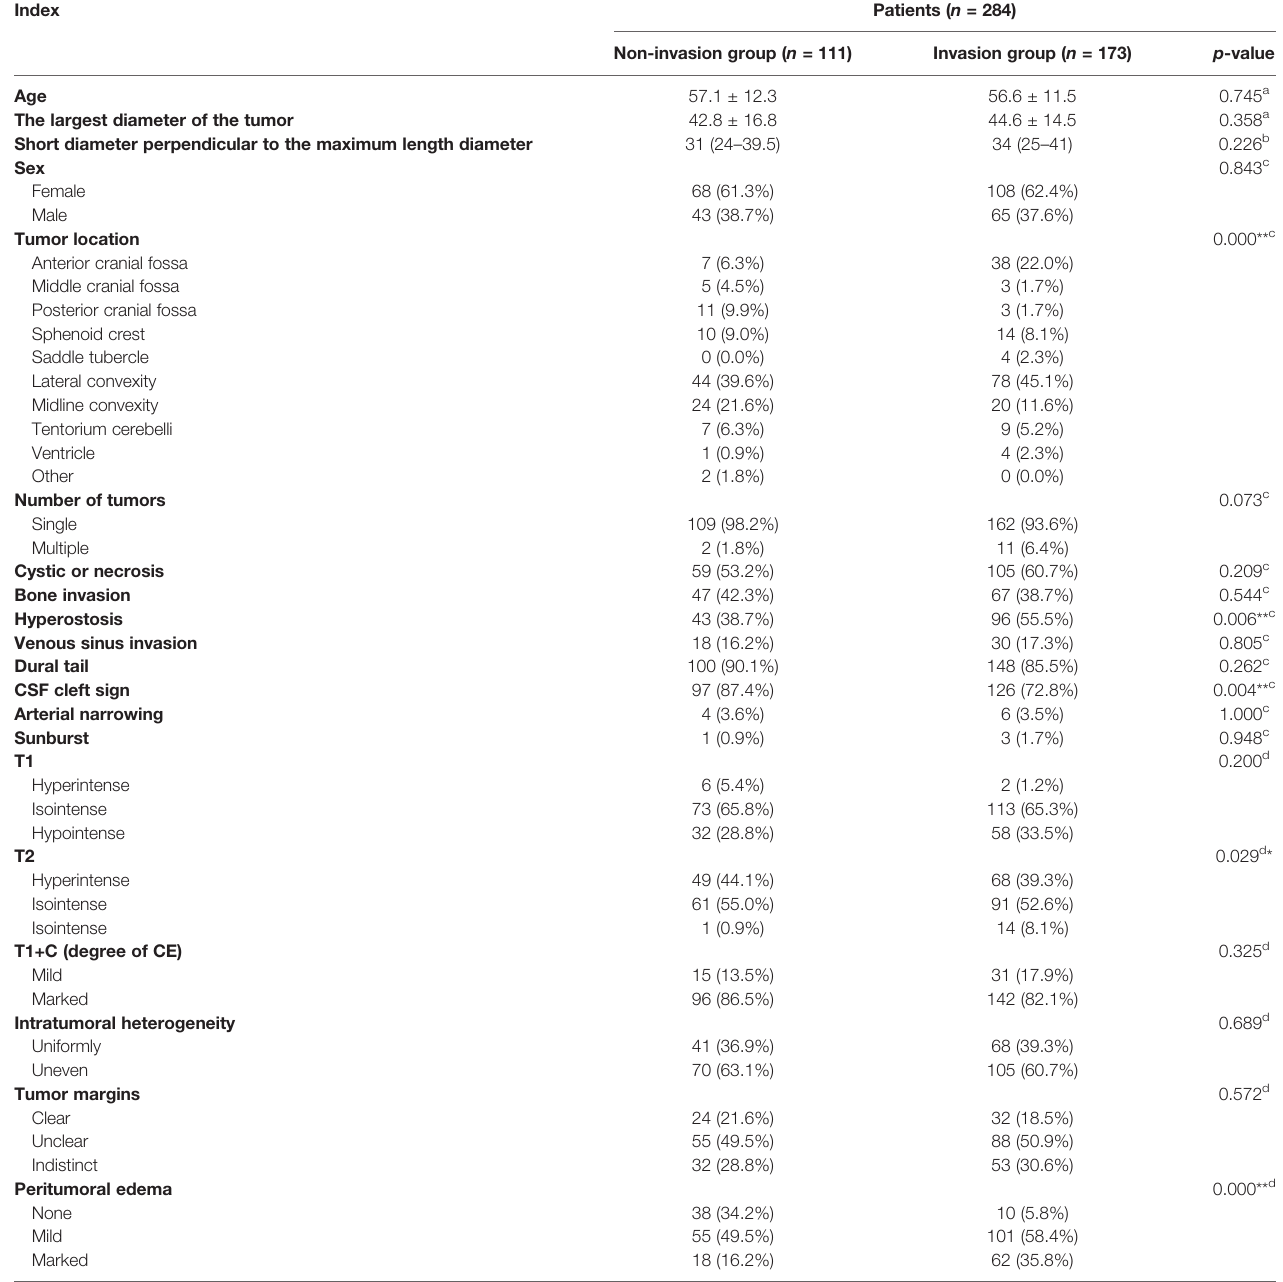
TABLE 1 | Demographic information of the 284